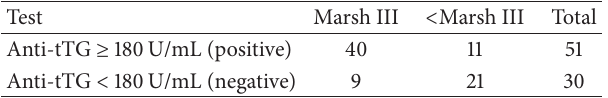
Table 4: Assessment of sensitivity, specificity, positive